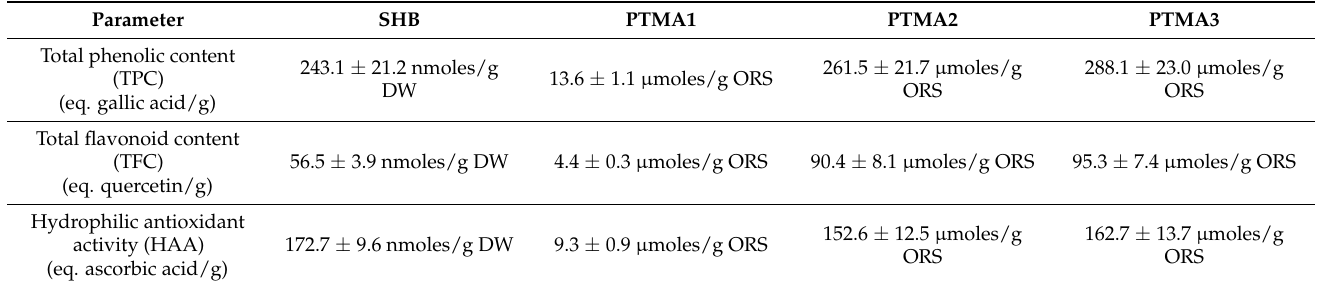
Table 3. Specific analysis of selected herbs (SHB) and the final products